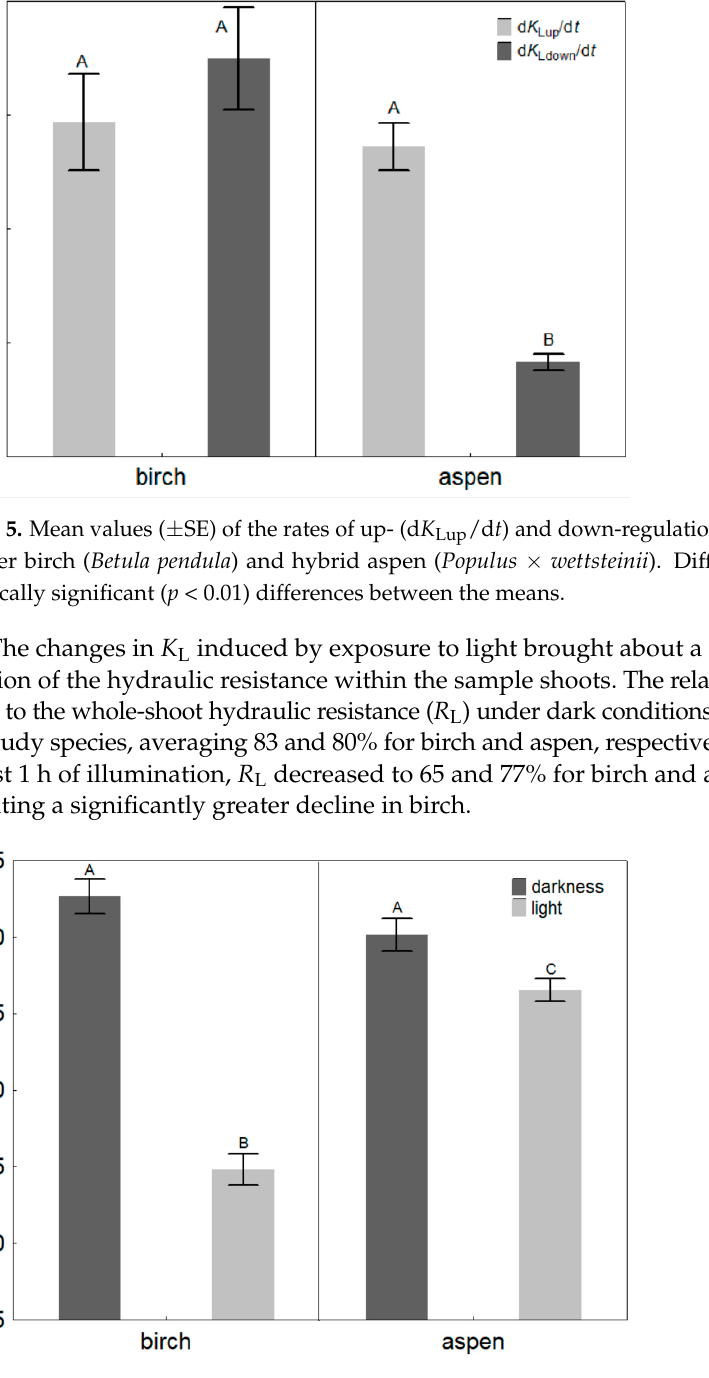
9 of 16 Figure 4. Relationship between leaf mass per area (LMA) and time of K L up-regulation ( t up ) across species. All data points correspond to one shoot.